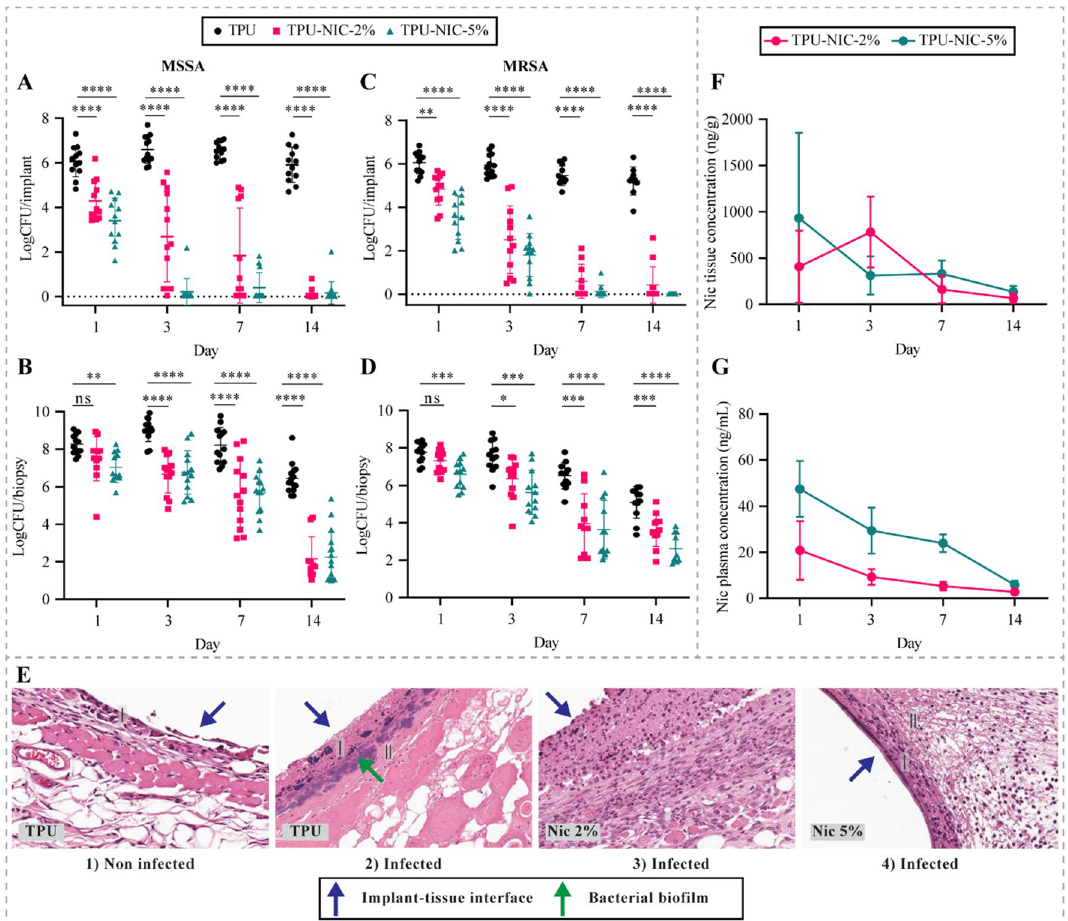
Figure 8. Antibacterial evaluation of TPU catheters loaded with 2 and 5% of NIC at 1, 3, 7 and 14 days after implantation and infection in the mouse BAI model. In vivo efficacy of NIC-loaded catheters on MSSA colonization of ( A ) catheters and ( B ) peri-catheter tissue. Efficacy of NIC-loaded catheters on MRSA colonization of ( C ) catheter and ( D ) peri-catheter tissue. ( E ) Histological analysis of MSSA subcutaneous biofilm infections in peri-catheter tissue sections of animals implanted with non-loaded and NIC-loaded catheters (I) Infiltration of neutrophiles/macrophages, (II) Fibrin deposition. Mice carrying non-loaded catheter segments in absence of infection were used for baseline histological observations. Pharmacokinetic profiles of NIC released from catheters loaded with 2 and 5% NIC over 14 days. Concentration of NIC ( F ) in peri-catheter tissue and ( G ) in plasma. *Indicates a p -value of 0.01 to 0.05, **indicates a p -value of 0.001 to 0.01, *** p -value of 0.0001 to 0.001, ****indicates a p value < 0.0001, ns indicates a non-significant p